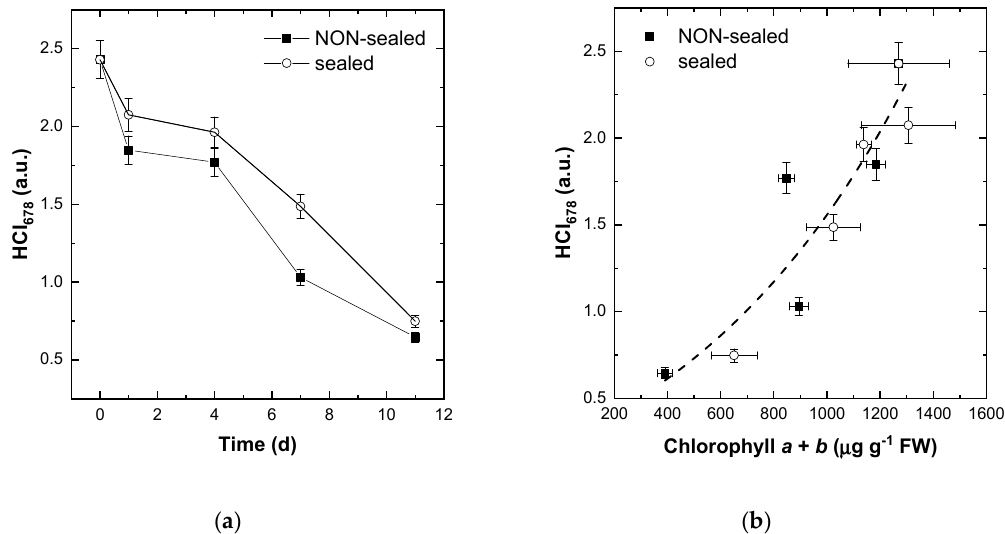
Figure 7. Changes in the average values of the index HCI678 during ( a ) storage of and ( b ) decline of Chl (indicative of leaf bleaching) in the stored non-sealed (closed symbols) and sealed (open symbols) fresh-cut lettuce leaves. See also Figures S2 and S3.